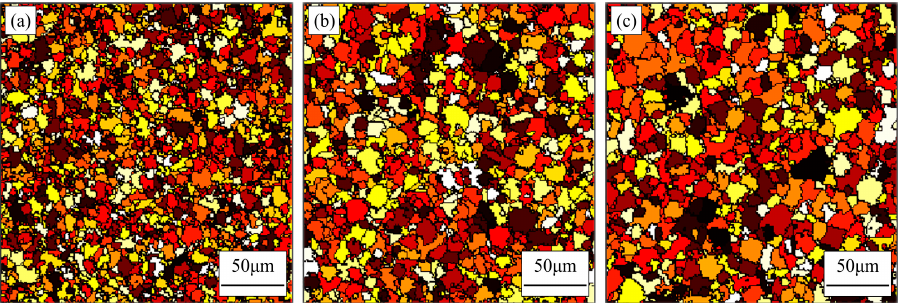
Figure 5. Microstructures of FeMnSiCrNi SMA undergoing compression ( T = 850 ◦ C, ε = 0.9) using CA simulation: ( a ) 0.5 s − 1 ; ( b ) 0.05 s − 1 ; ( c ) 0.005 s − 1 .